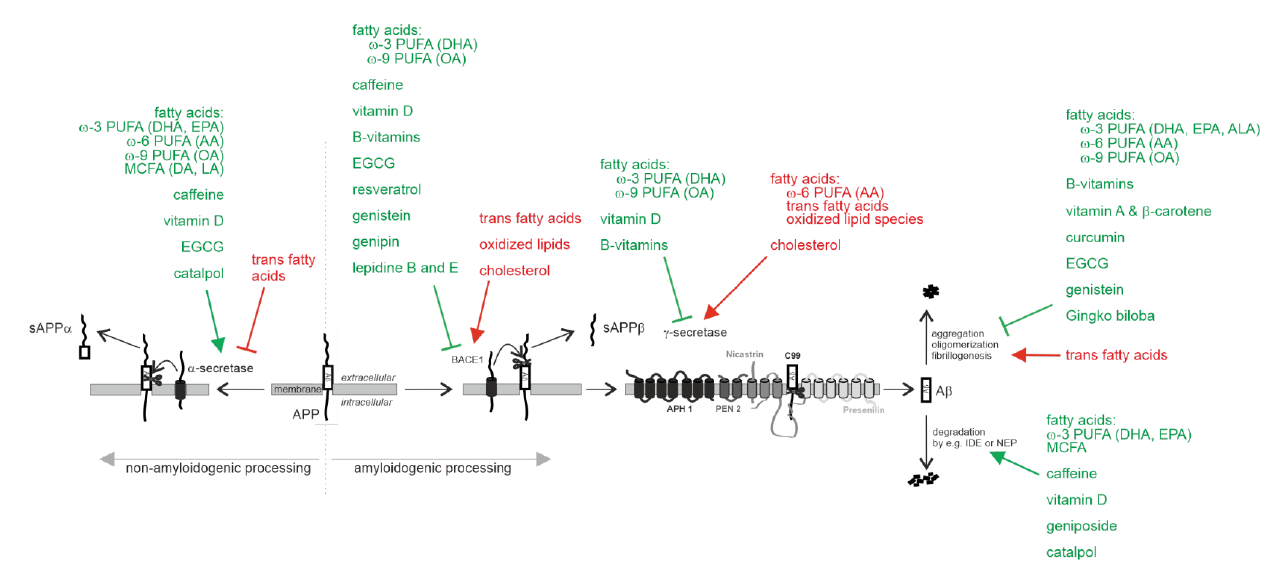
Figure 1. Influence of nutritional components on Aβ pathology. PUFA: polyunsaturated fatty acid. DHA: docosahexaenoic acid. EPA: eicosapentaenoic acid. AA: arachidonic acid. MCFA: medium-chain saturated fatty acids. OA: oleic acid. DA: decanoic acid. LA: lauric acid. EGCG: epigallocatechin gallate.